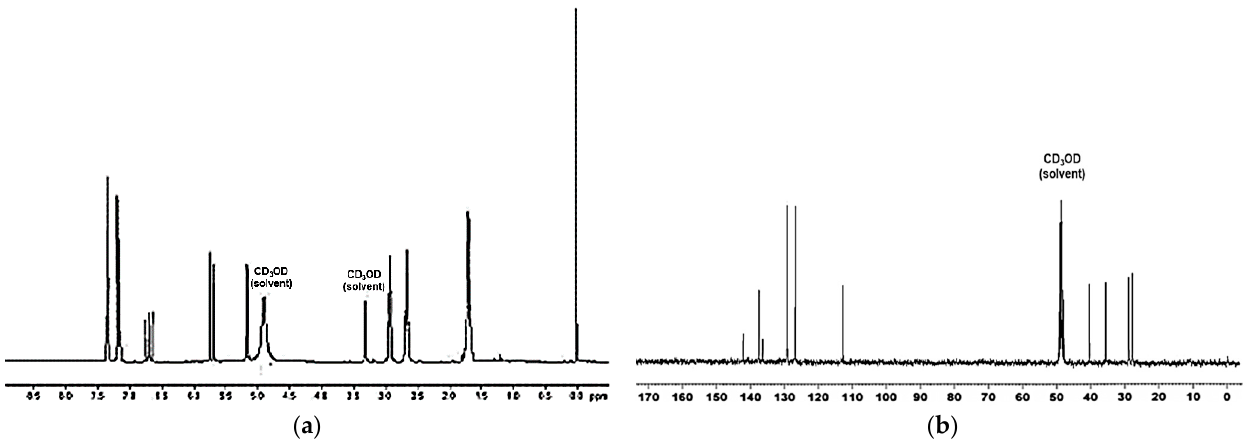
Figure 2. 1 H NMR (300 MHz), and ( a ) 13 C NMR (75.5 MHz), ( b ) spectra of monomer M5, ( 5 ) acquired in CD 3